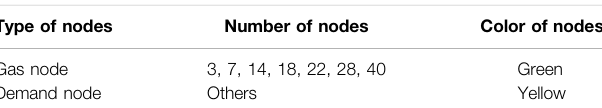
TABLE 2 | The node classi fi cation table.